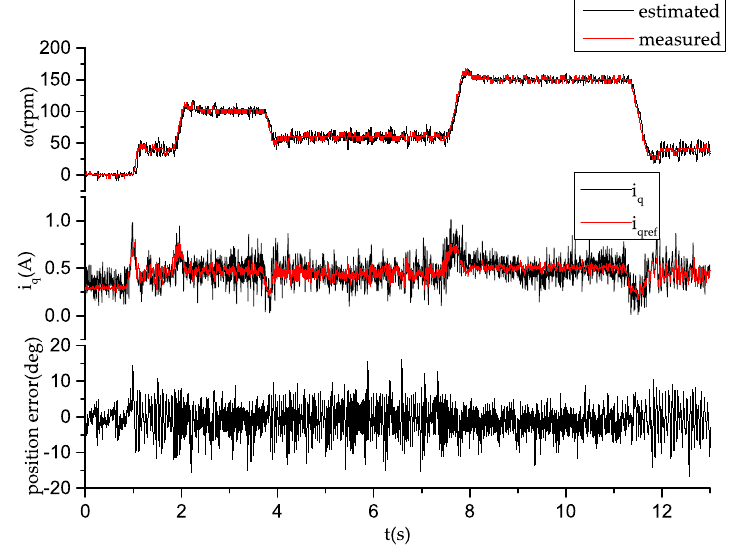
Figure 17. Experimental results of speed reference steps with no load torque, including the waveforms of actual and estimated speed, current i q and i q reference and position estimation